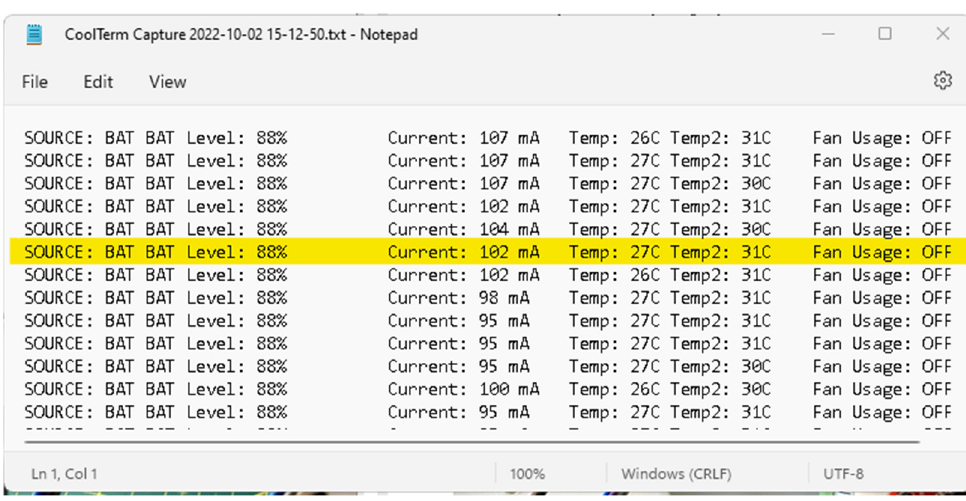
Figure 24. Recorded data from the power supply using CoolTerm.